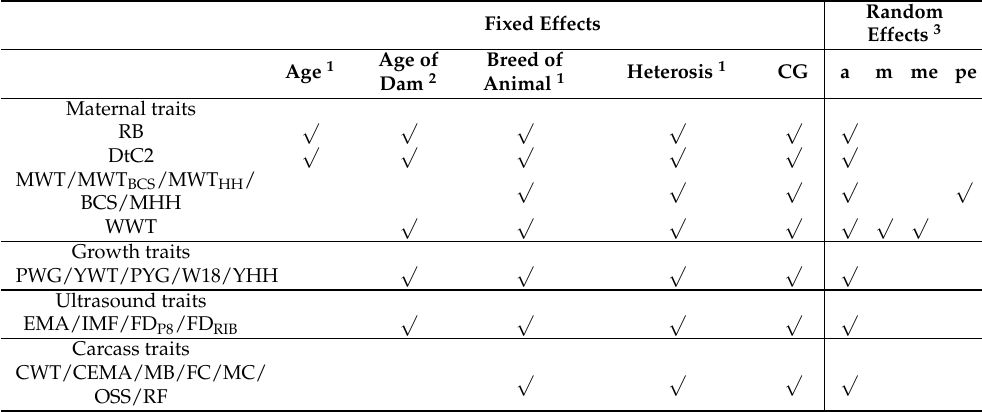
Table 3. Fixed effects and random effects for each trait included in the variance component